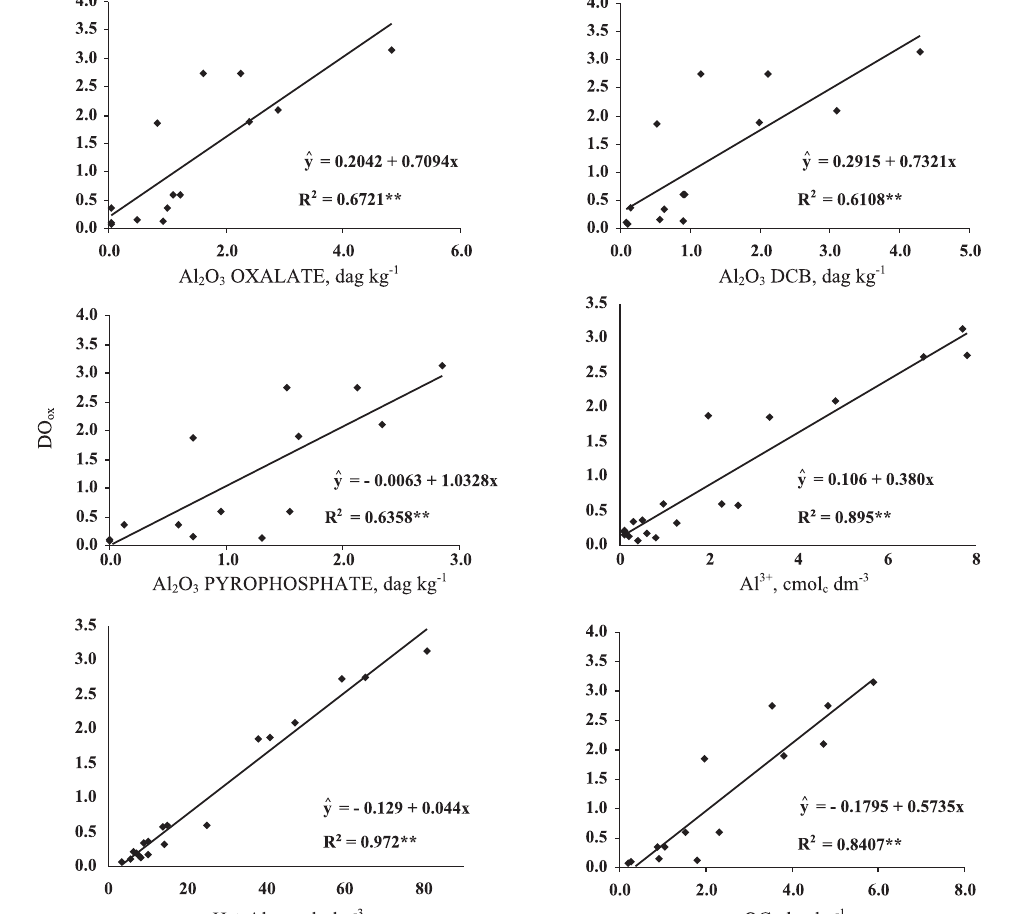
Figure 3. Relations between the values of optical density of the extract of ammonium oxalate (DOox) and Al O extracted by ammonium oxalate, DCB and sodium pyrophosphate, Al 3 +, H + Al, organic C spodic 2 3 horizons of soil